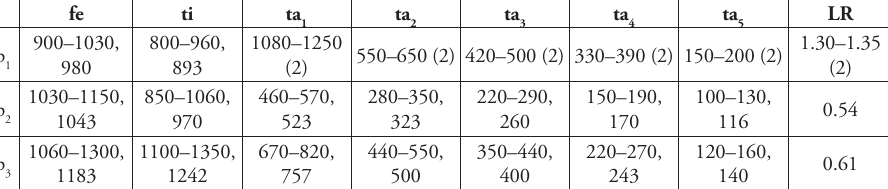
Table 1. Lengths (µm) and proportions of adult male legs in Parachironomus frequens (Johannsen), (n=3). fe ti ta